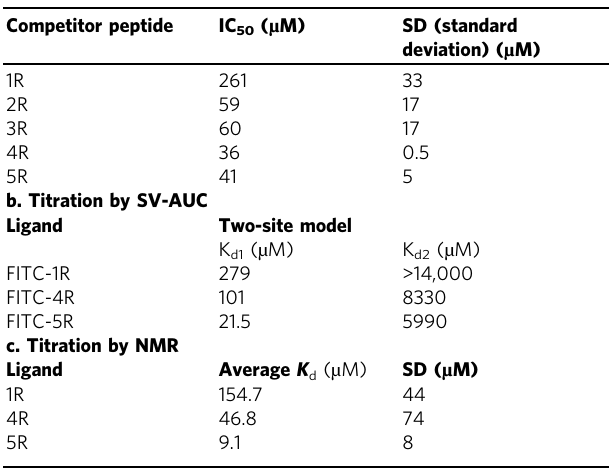
Table 3 Summary of Ess1-CTD binding af fi nities. a. Competition anisotropy (vs. FITC-1R) Competitor